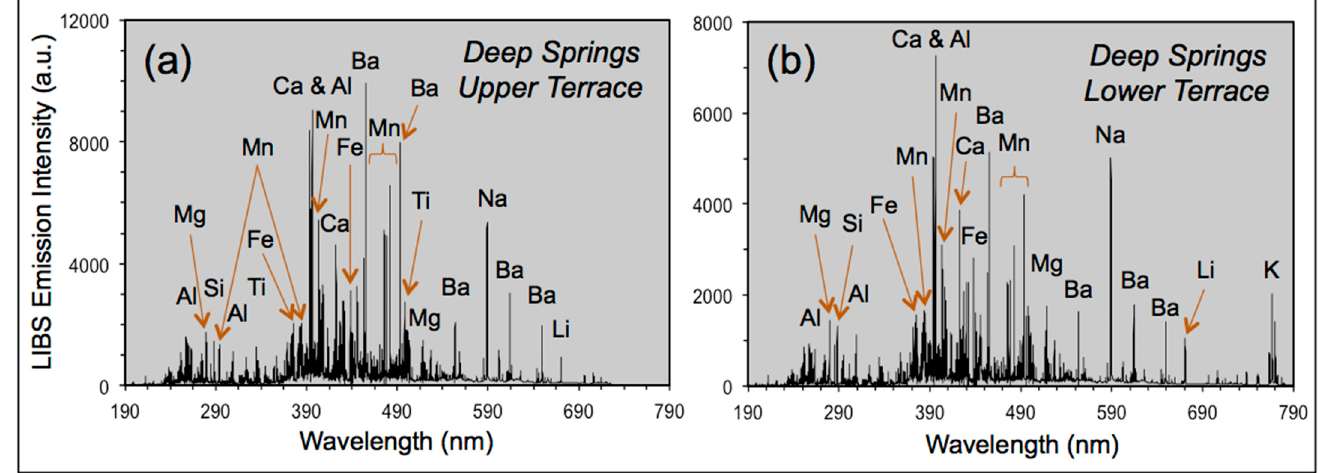
Figure 8. LIBS spectra for varnished clasts on the desert pavement covering alluvial fans on the upper and lower terraces in Deep Springs Valley.